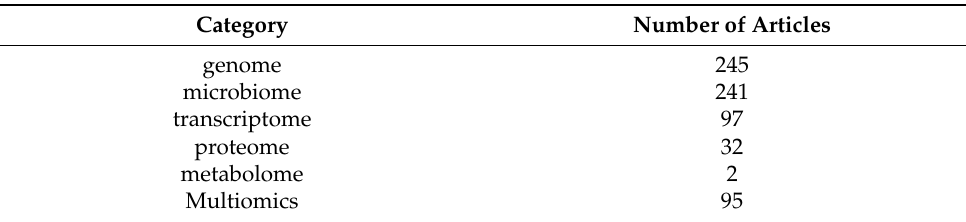
Table 3. Omics categorization of the literature from omics studies concerning skin diseases with alterations in the Notch signaling pathway.